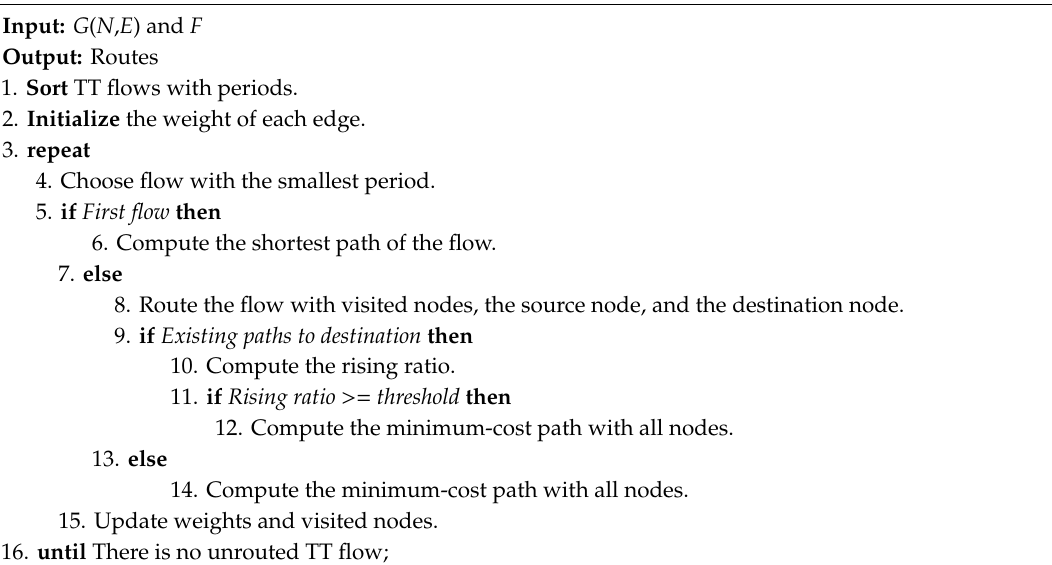
Algorithm 1 : Proposed Routing